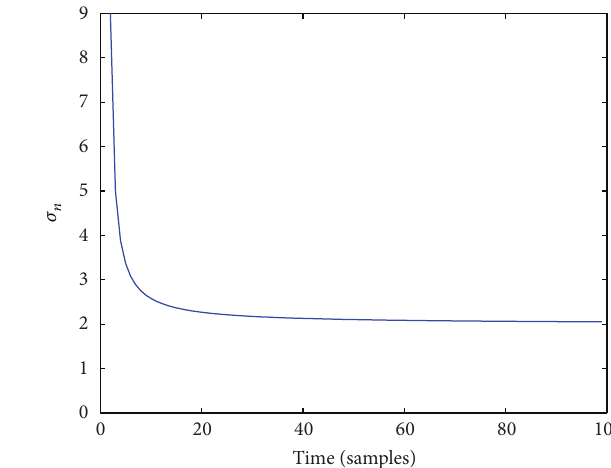
Figure 5: Evolution of the weights under (39).